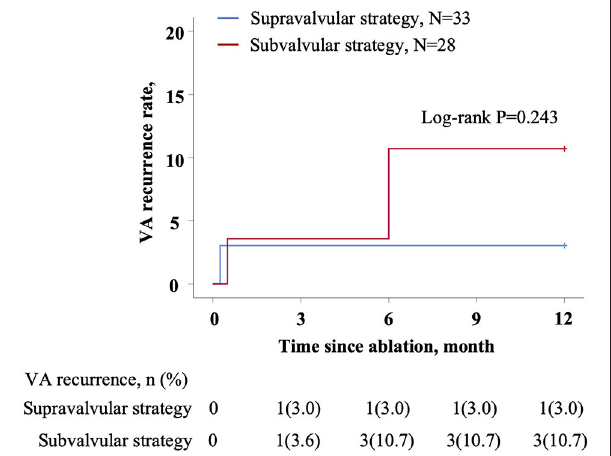
FIGURE 5 | Kaplan–Meier estimates of the accumulative VA recurrence of 12 months. Patient number (frequency) was shown at the bottom. p -value was shown on the graph. IA, initial ablation; VA, ventricular arrhythmia.